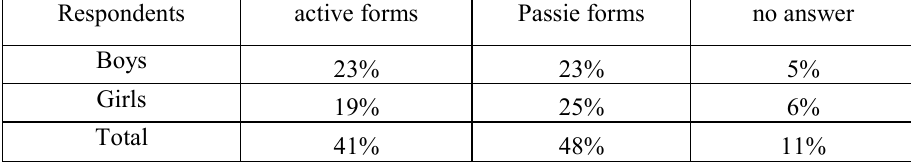
Table 2. Forms of spending leisure time chosen on my own